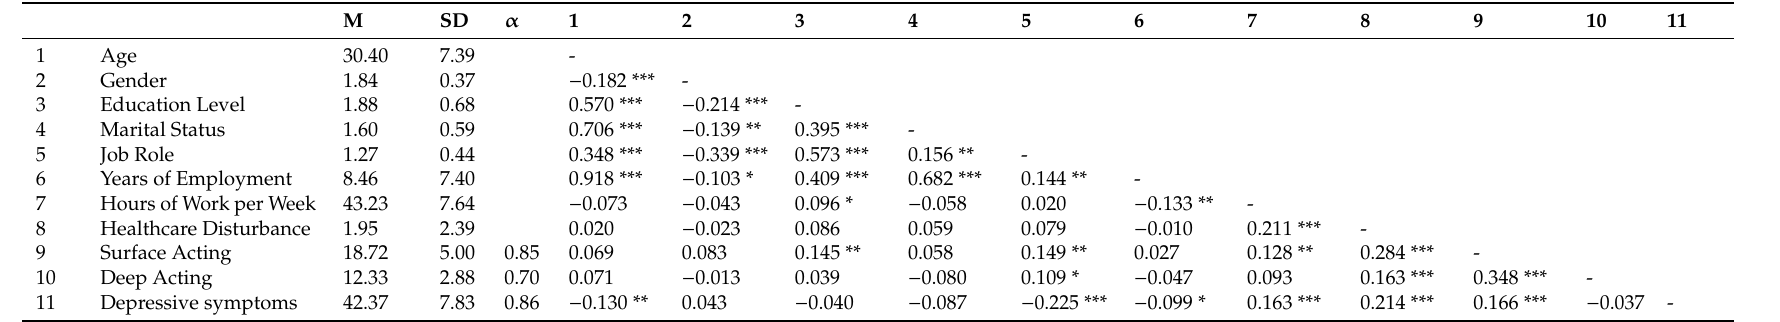
Table 2. Respondents reports of demographic variables, healthcare disturbance, surface acing, deep acting, and depressive symptoms: descriptive statistics, correlations, and reliability coe ffi